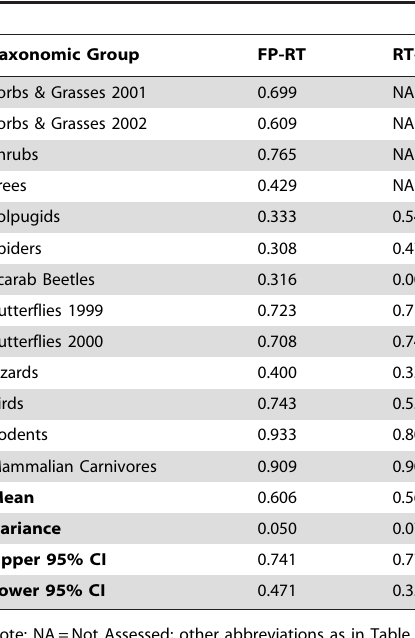
Table 2. Sørensen similarity values for habitat type pairs.